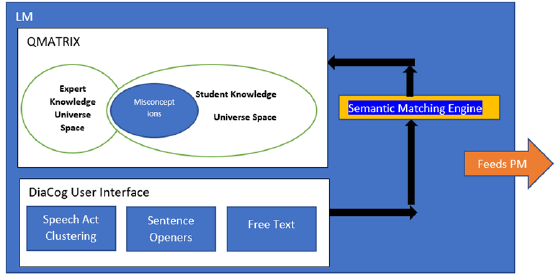
Figure 3. LM Design for